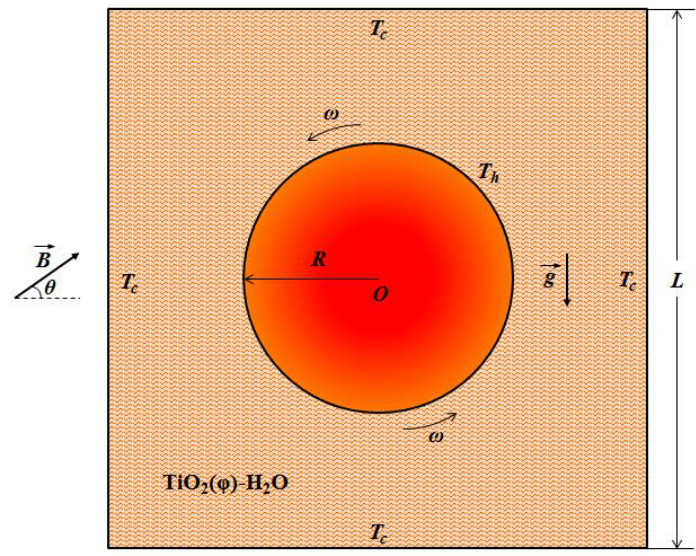
Figure 1. Schematic diagram of the problem in this